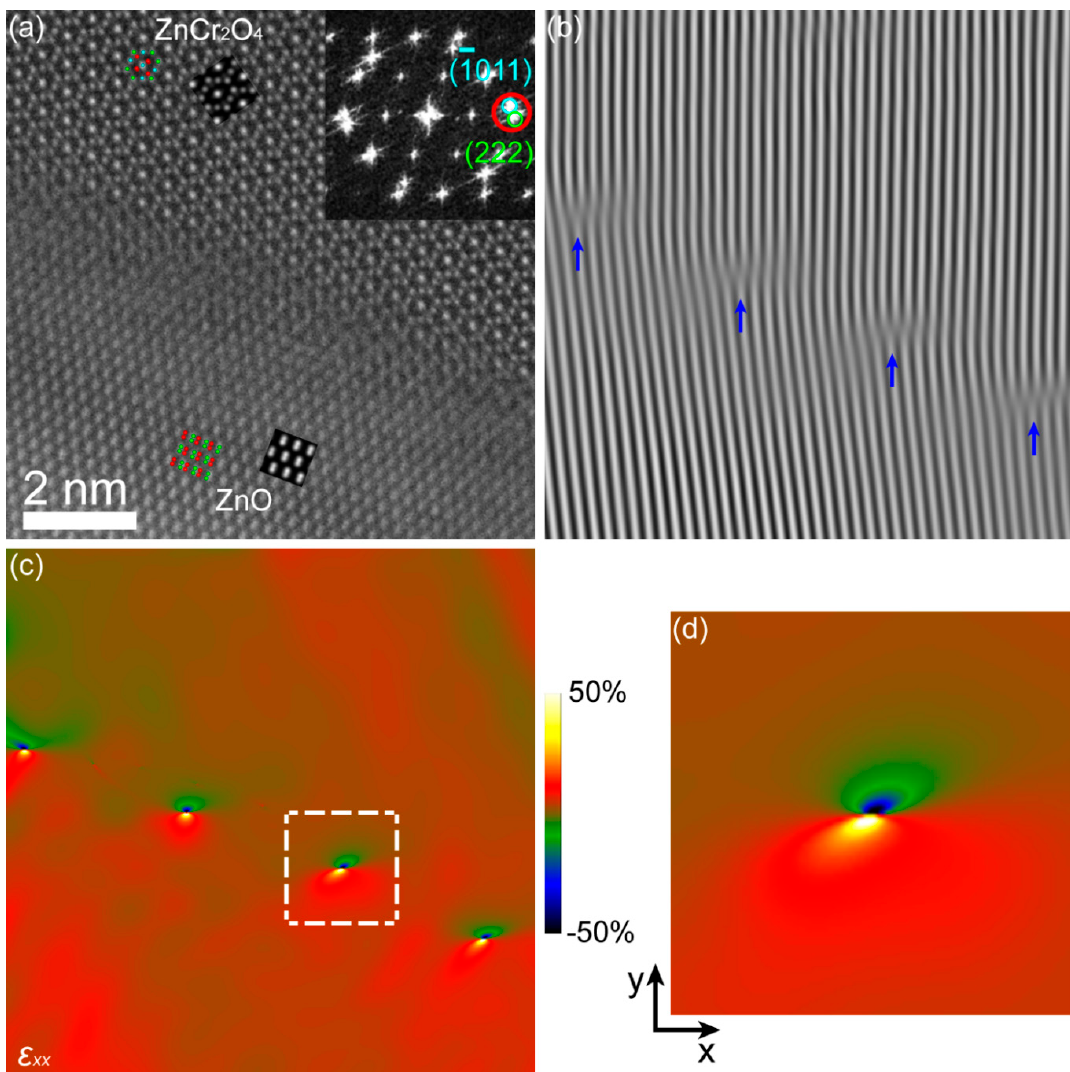
Figure 5. ( a ) High-angle annular dark-field (HAADF) image of ZnO [2 1(cid:3364)1(cid:3364) 3]/ZnCr 2 O 4 [1 1(cid:3364) 0] interface. The inset at the upper right of the HAADF image displays its fast Fourier transform (FFT), and the circles show the lattice fringes. The simulated images and the corresponding projected models of ZnO and ZnCr 2 O 4 are also inserted, and their close-ups are displayed in Figure S3b,c (Supplementary Materials). ( b ) Fourier-filtered image of ( 1(cid:3364) 011) ZnO /(222) ZnCr2O4 lattice fringes with blue arrows indicating the dislocation lines. ( c ) Geometric phase analysis (GPA) ε xx maps. ( d ) Close-up of the white square in ( c ).